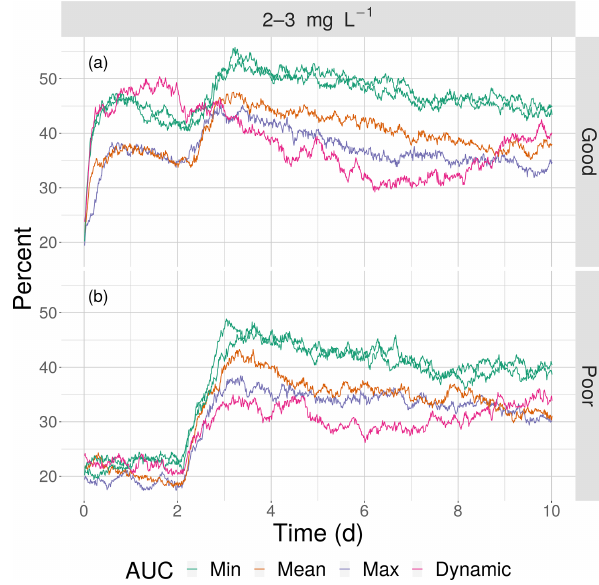
Figure 11. Cumulative exposure (days) of each individual fish to DO concentrations of 2–3mgL − 1 for good (left) and poor (right) competency for each of the four snapshot DO maps with moderate sublethal area and the dynamic version. Maps within the same AUC category (min and mean) are shown with the same color.